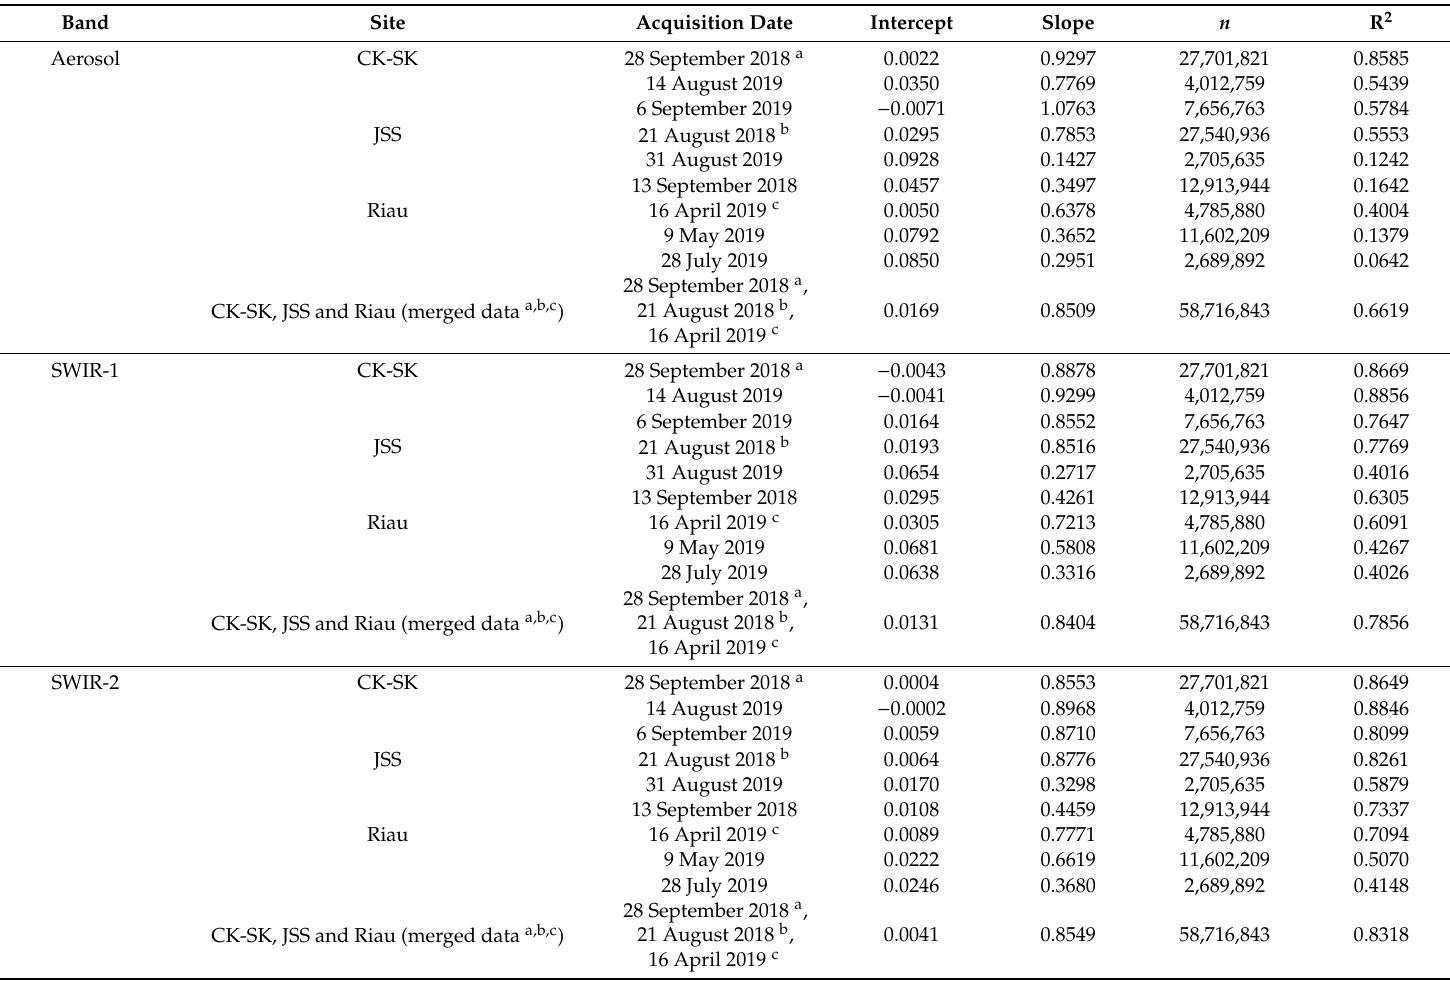
Table A3. Landsat-8 OLI TOA reflectance as a function of Sentinel-2 MSI TOA reflectance at aerosol, SWIR-1, and SWIR-2 bands. Intercept and slope were derived from the ordinary least squares (OLS) regression of total data ( n ). The coe ffi cients of determination (R 2 ) were significant at p -values < 0.001. The data sites were Central Kalimantan and South Kalimantan (CK-SK), Jambi and South Sumatera (JSS), and